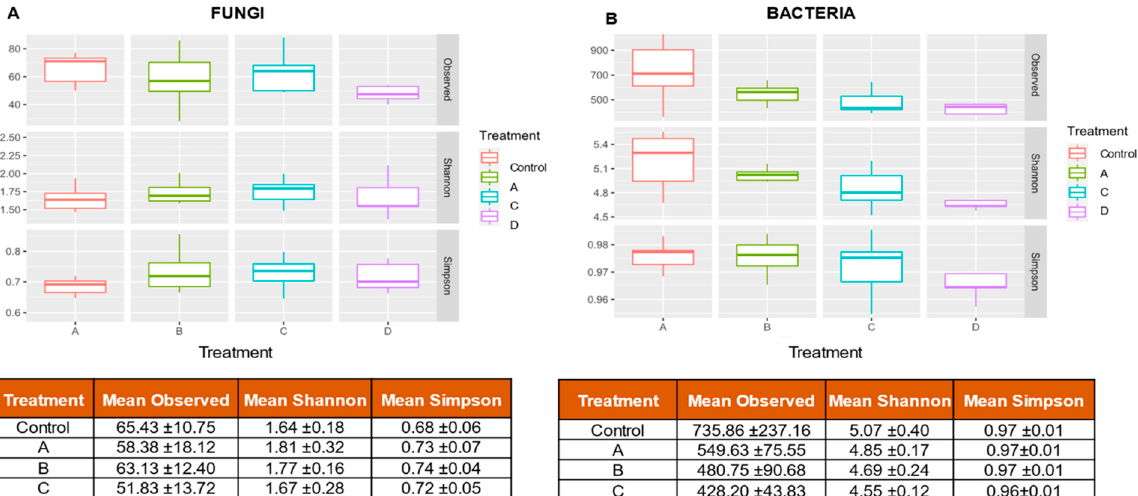
Figure 1. Alpha diversity. Graphic representation of the alpha diversity as a box plot and values in tables (median with 0.25 and 0.75 quantiles). ( A ) Observed diversity and the Shannon and Simpson indices for fungi. ( B ) Observed diversity and the Shannon and Simpson indices for bacteria.